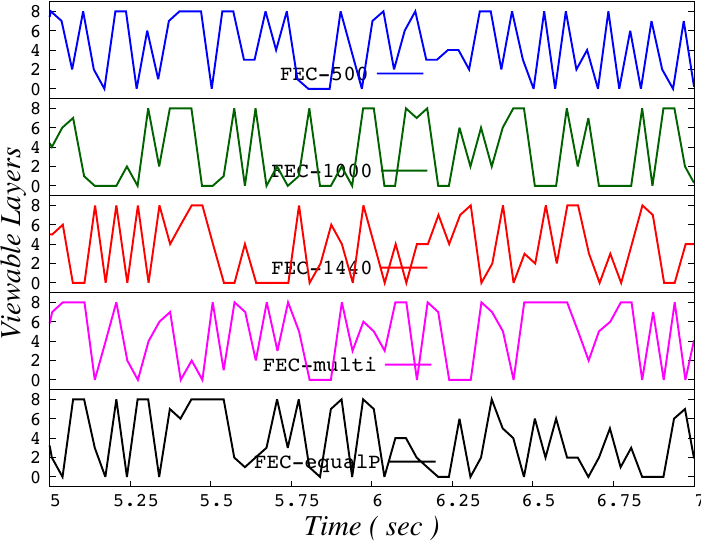
Figure A5. A two-second example of variation in viewable quality for all FEC models, at a packet loss rate of 10%.